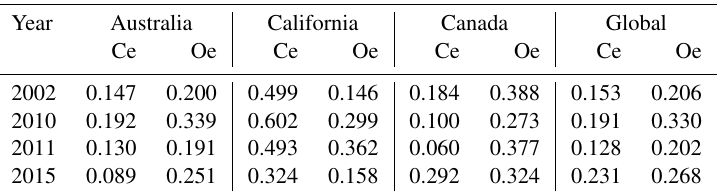
Table 4. Agreement between FireCCI50 and national fire perimeters for the selected test areas. Ce denotes commission errors, and Oe denotes omission errors, assuming fire perimeters to be the